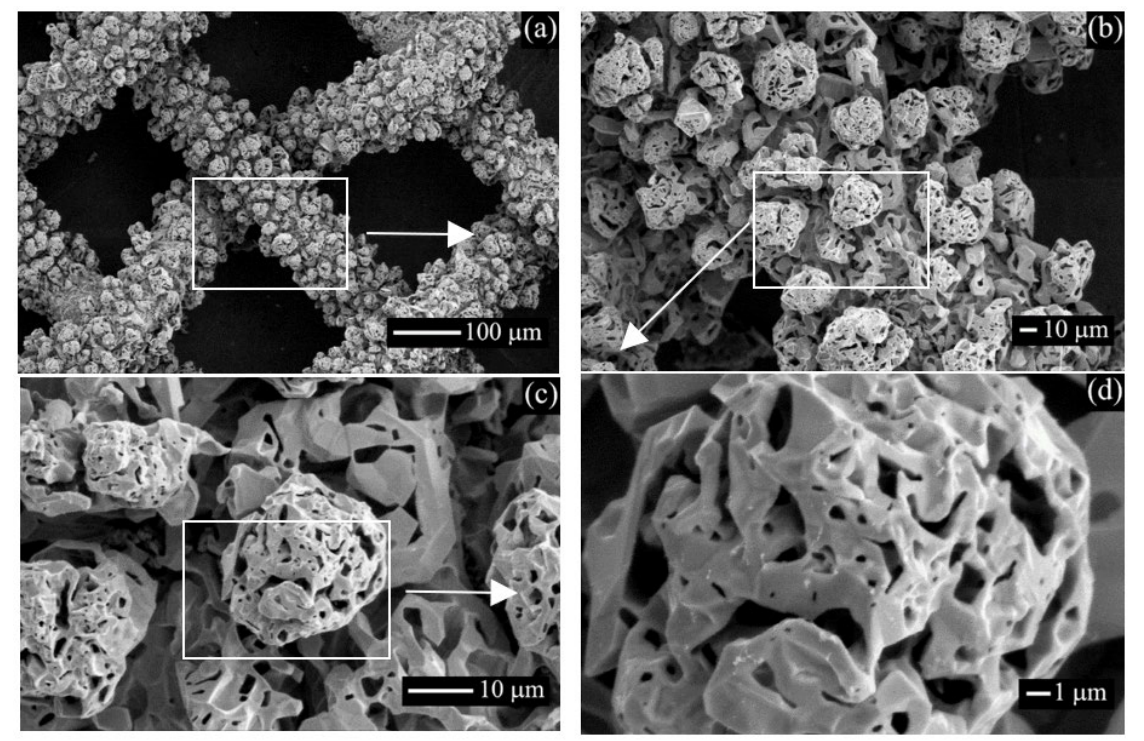
Figure 1. SEM images of a fragment of the Pt−Pd−Rh−Ru gauze ( a , b ) and “cauliflowers” ( c , d ) after NH 3 oxidation with air in an industrial reactor at T ~1173 K and P ~7.0 bar for ca. 3000 h. Images were obtained at E 0 = 16 keV in the secondary electron (SE) mode. Rectangles indicate the regions represented by the images that were obtained at a greater magnification.